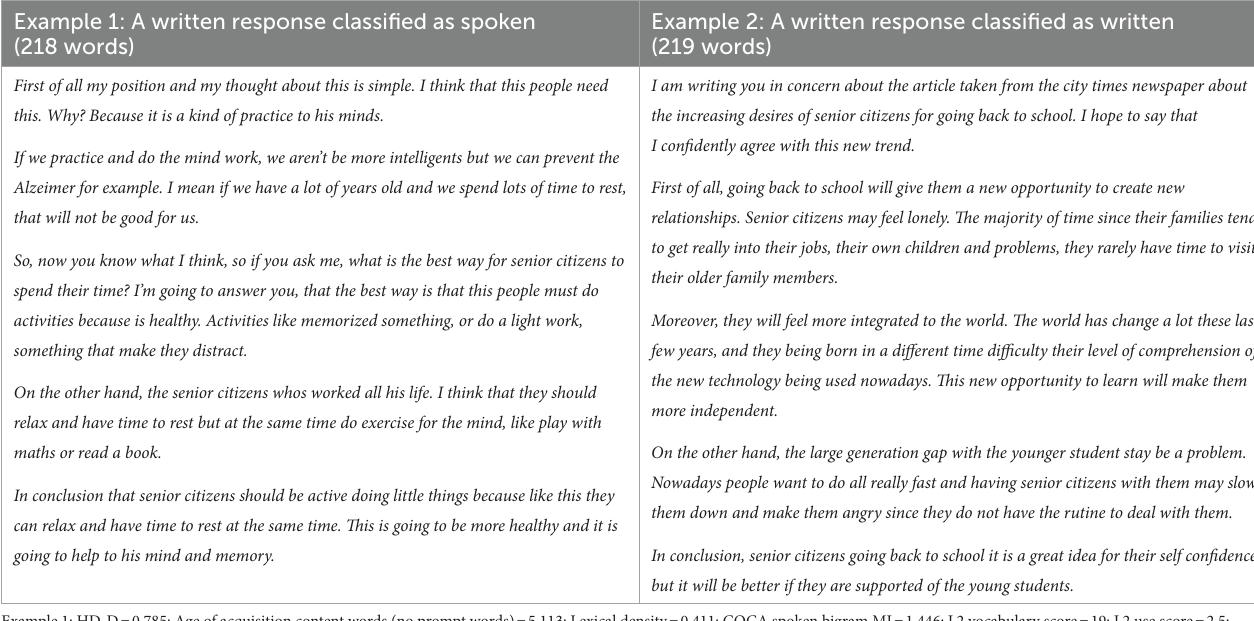
TABLE 8 Examples of L2 written opinion responses. Example 1: A written response classified as spoken (218